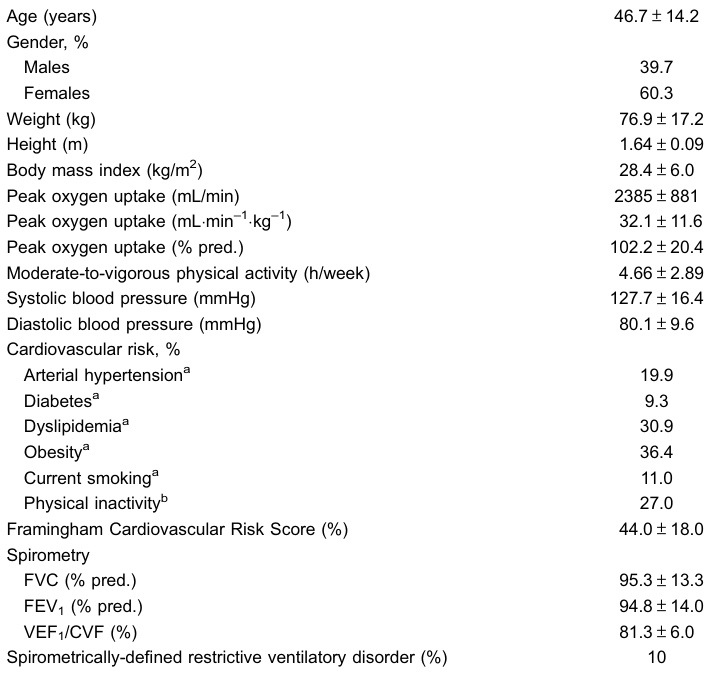
Table 1. General characteristics of the study sample (n=1362).